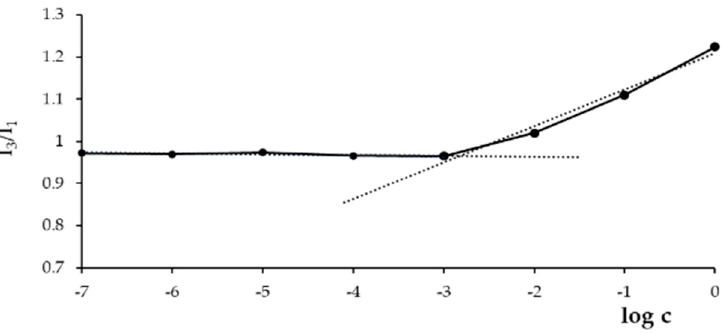
Figure 3. Dependence of pyrene fluorescence spectrum signals on HAssHSA concentration at pH 7.4.